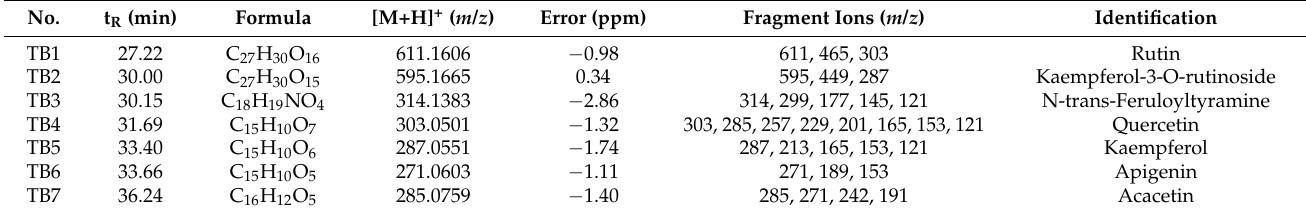
Table 1. Mass spectrometric information of proposed major chemical components in Tartary buck- wheat extracts.